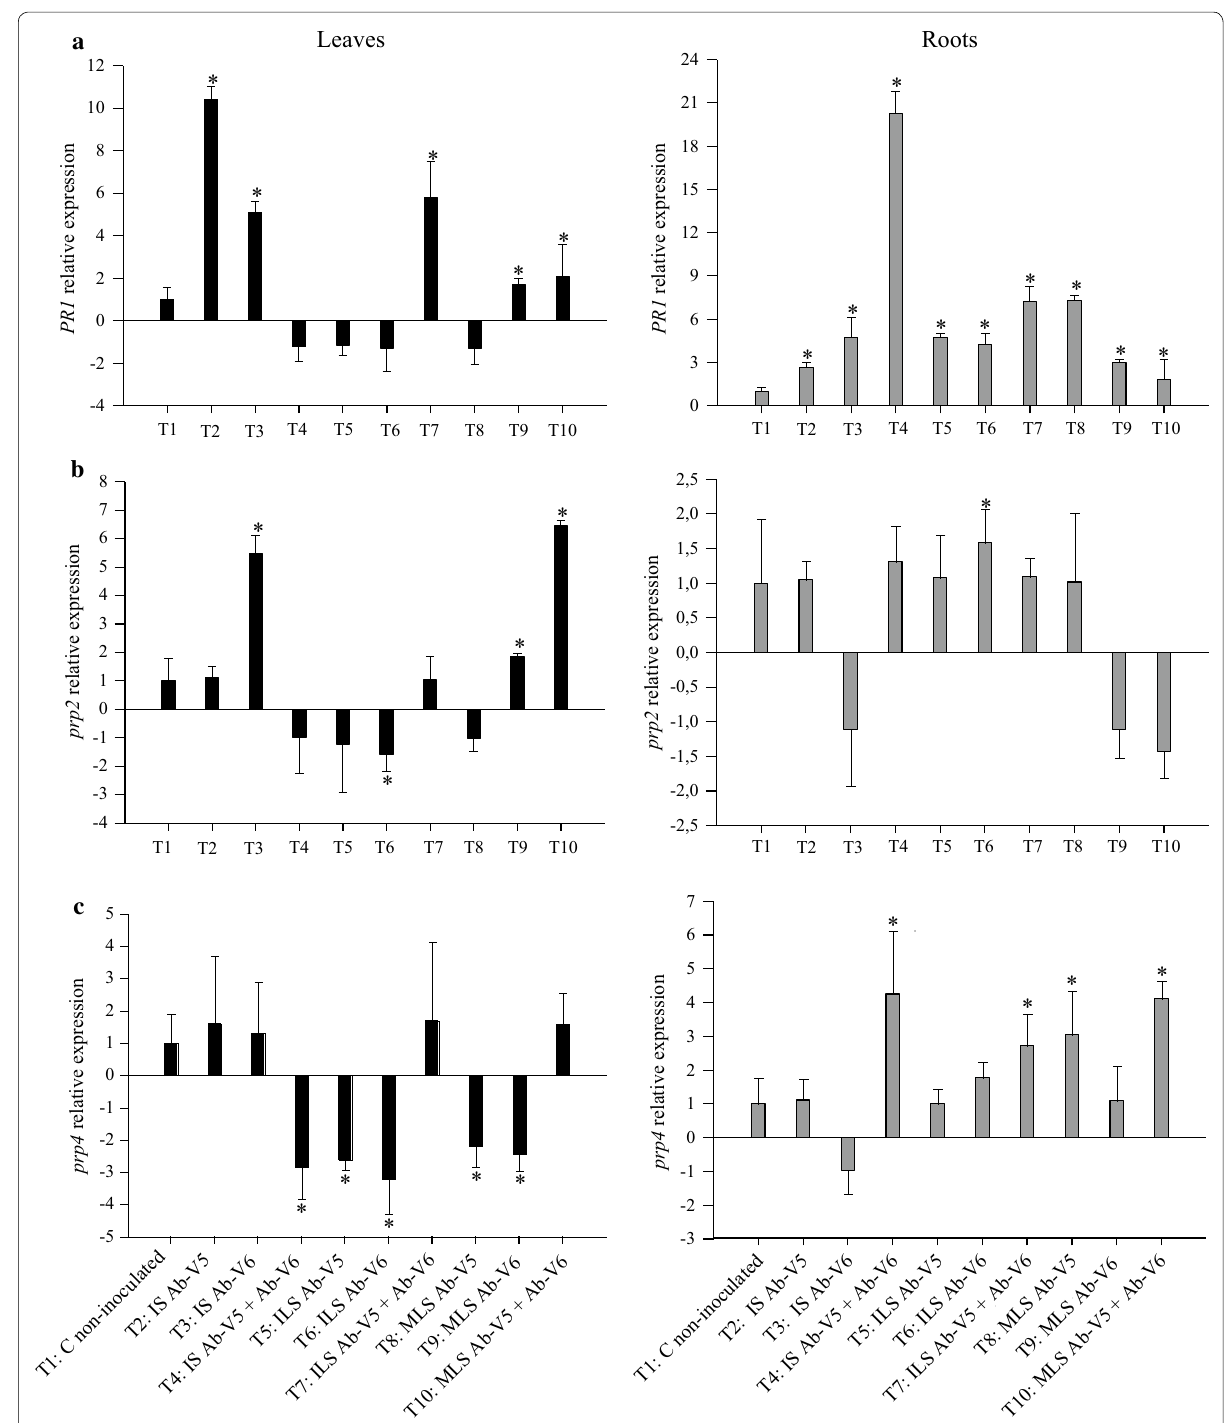
Fig. 3 RT-qPCR analysis of the expression of several a PR1 , b prp2 and c prp4 genes, as described in the legend of Fig.